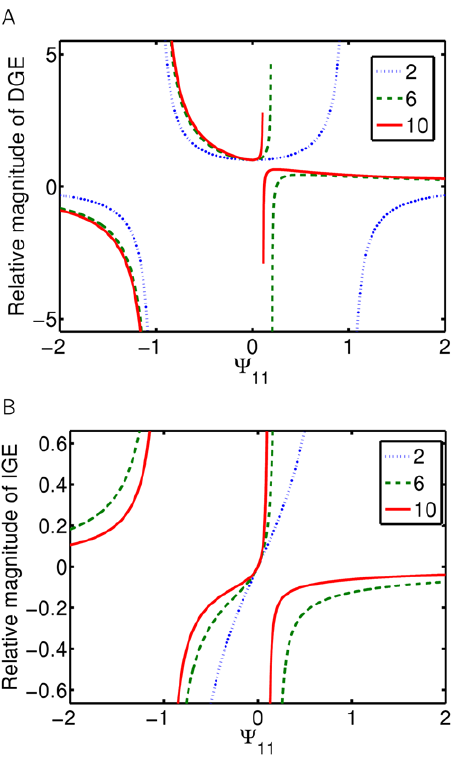
Figure 4. Interactions with feedback at the trait level: direct and indirect genetic effects. Relative magnitude of direct (A) and indirect (B) genetic effects and their dependence on the strength of the interaction, for different numbers of individuals (two, six and ten individuals). Interaction as depicted in Figure 1 C, where Y 11 is the strength of the interaction between trait X of the focal individual and the same trait in its social partner.